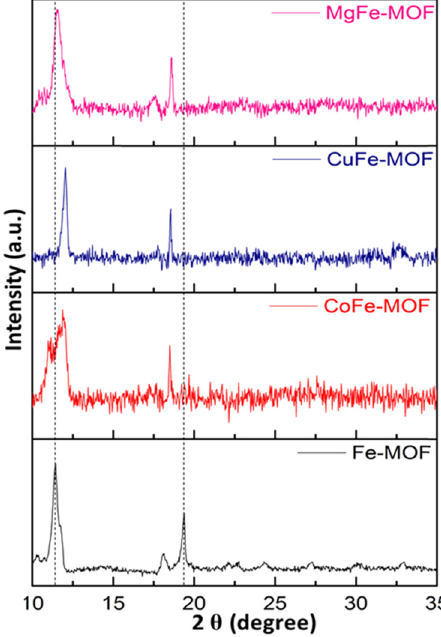
Figure 1: XRD patterns of M/Fe - MOF ( M = Co, Cu, and Mg )